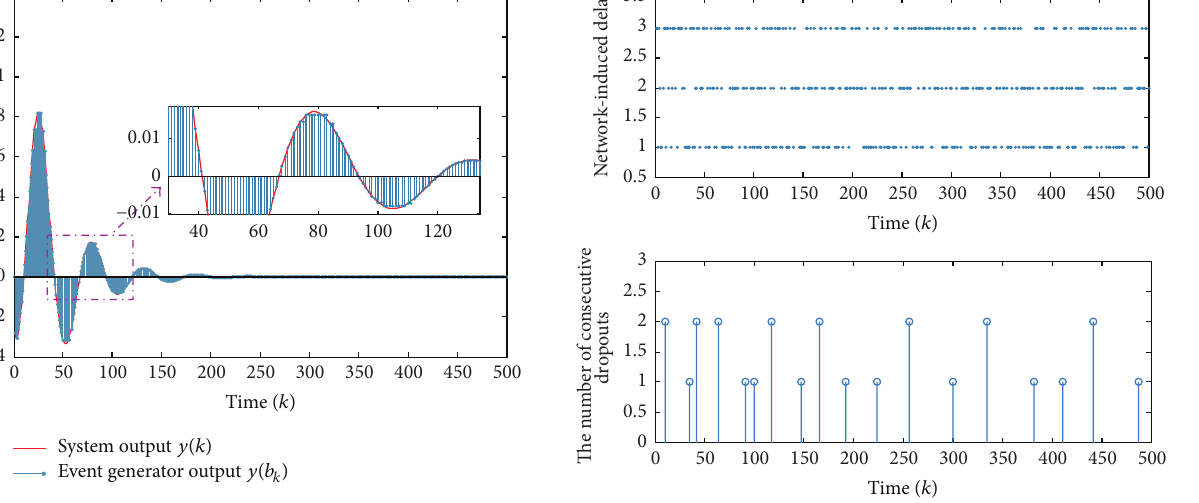
Figure 5: The network-induced delay and data packet loss.